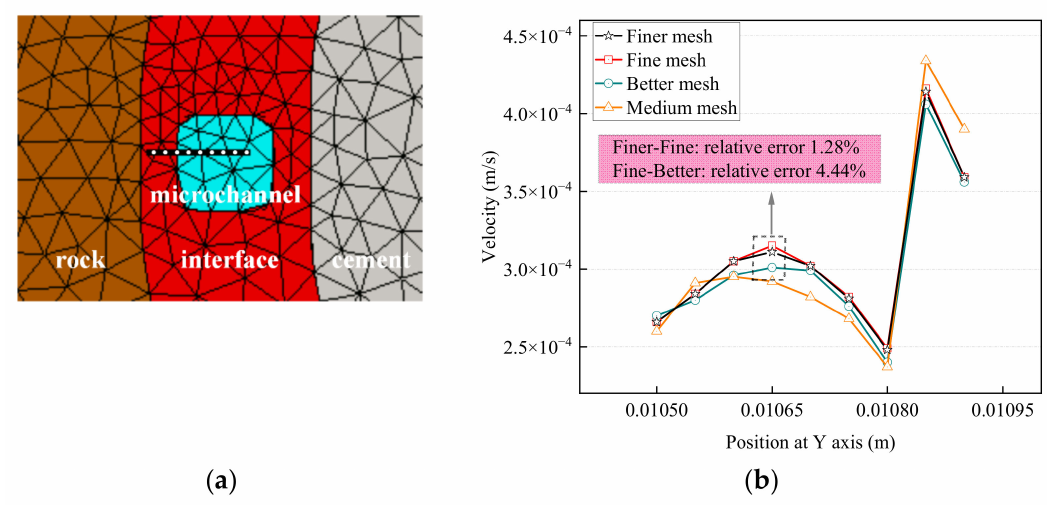
Figure 11. Positions of selected velocity measuring points ( a ) and corresponding velocity profiles under different meshes ( b ).